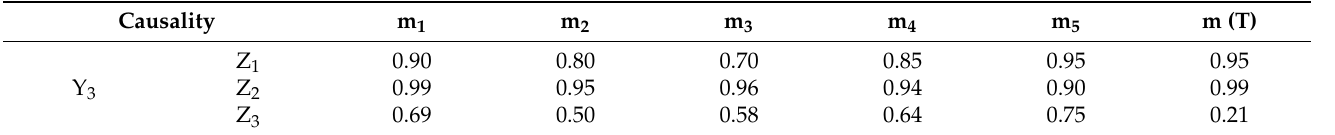
Table 7. Calculation results of node